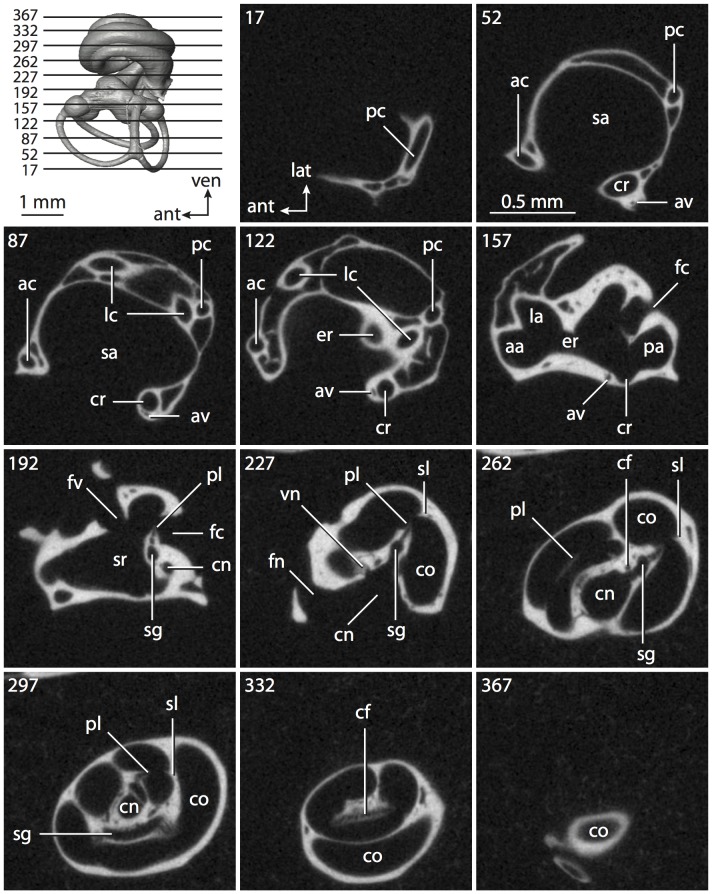
CT slices through ear region ofTadarida brasiliensis.Abbreviations listed at the end of the Materials and Methods section.